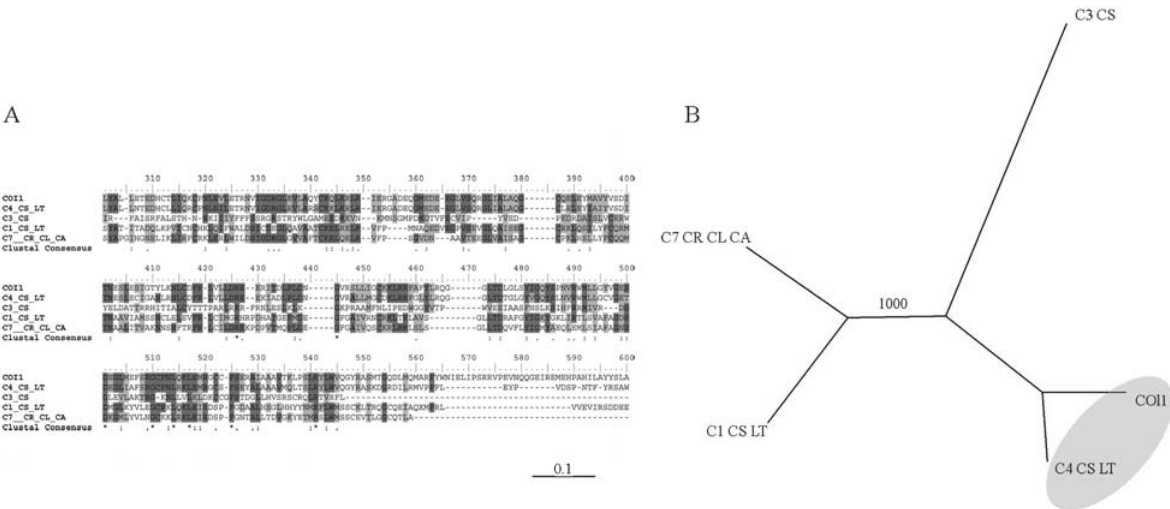
Figure 3 - Jasmonates-mediated signal transduction in citrus. Alignment of the degenerated F-box domain from A. thaliana and citrus COI1 proteins. Phylogenetic analyses of the deduced amion acid sequence of citrus COI1 homologs and full length A. thaliana counterpart. Phylogenetic analysis was performed as described. Shaded circle represents the AtCOI1 branch.